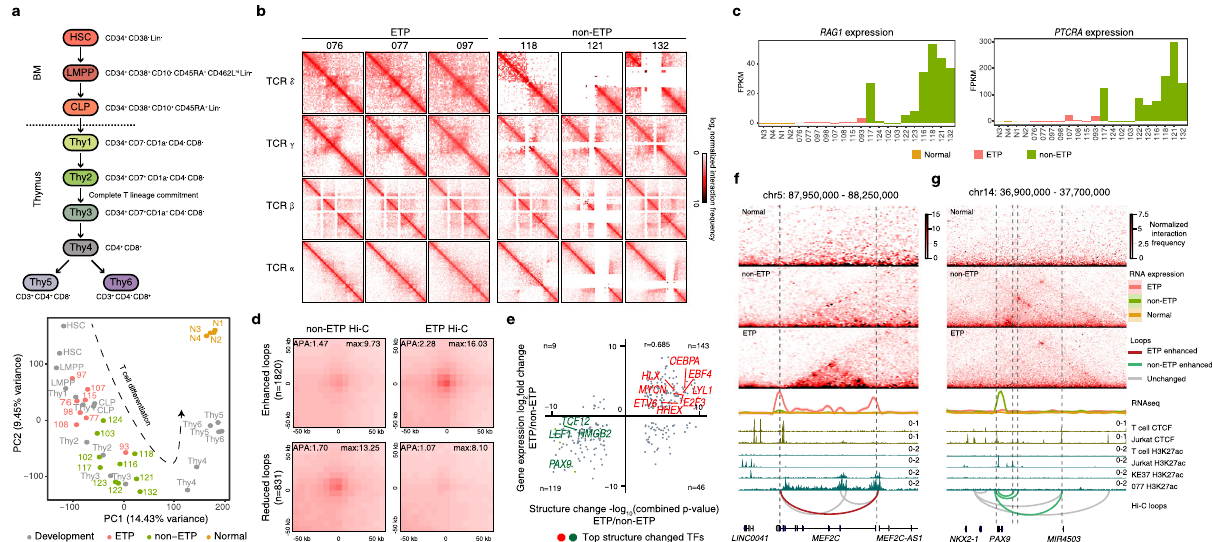
Fig. 2 ETP and non-ETP ALLs have different loop structures. a Upper: scheme of T-cell development of hematopoietic stem cell (HSC) and eight lymphoid cell types in human bone marrow (BM) and thymus analyzed by RNA-seq. Lower: PCA includes T-ALL cells and populations from normal human BM and thymus ( n = 2 biological replicates per population). The trajectory of T-lineage differentiation is labeled with dash line. b Hi-C contact maps for the TCR genomic regions in ETP and non-ETP ALLs. c RAG1 and PTCRA expression levels. d APA plots for loops that are enhanced (upper) or reduced (lower) in ETP compared with non-ETP ALL. e Scatterplot shows the correlation between gene expression and structural changes. The structural change was de fi ned by the combined p value of D-score and loop strength change. Top ETP and non-ETP ALL-associated transcription factors with structural changes are highlighted in red and green, respectively. Hi-C contact maps for TADs enclosing the genomic loci of ETP expressed MEF2C ( f ) and non-ETP expressed PAX9 ( g ). ChIP-seq tracks of CTCF and H3K27ac of normal T cells, non-ETP ALL Jurkat cells, and ETP ALL including KE37 cells and case 077 are also included. Unchanged, non-ETP-enhanced, and ETP-enhanced loops are labeled with gray, green, and red curves, respectively. Anchors of differential loops are labeled with dashed